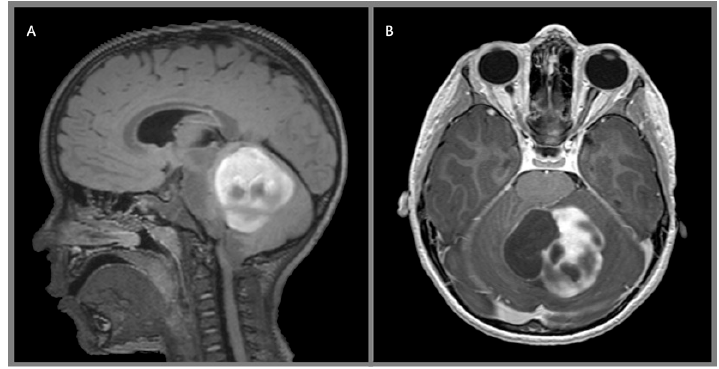
Figure 2. Juvenile pilocytic astrocytoma, WHO 1: ( A ) sagittal T2 FLAIR with contrast and ( B ) axial T1 with contrast demonstrate a heterogeneous, multicystic, avidly enhancing mass arising from the left cerebellar hemisphere.